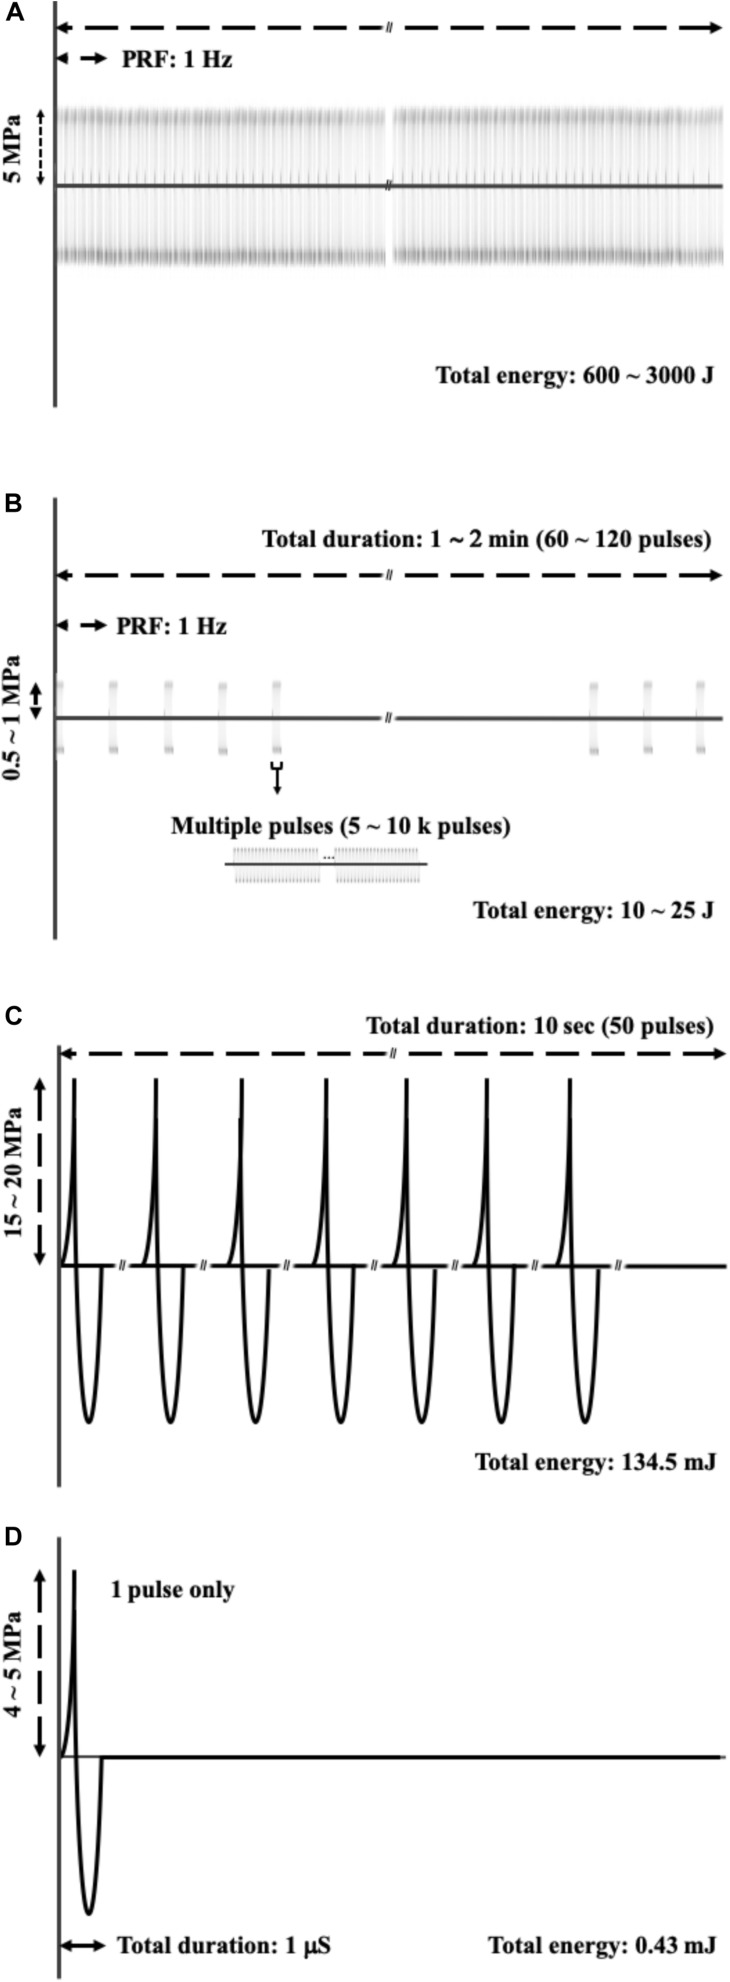
Comparisons of acoustic profile of (A) HIFU applied on the tumor ablation; (B) HIPU, the preferred method to induce BBB opening; (C) burst FSW (our previous study), which is also applied for BBB opening; (D) a single shot FSW, which is the method used in this study.